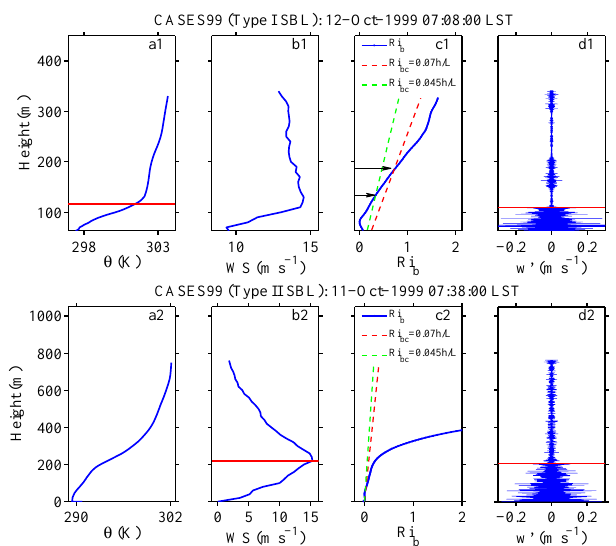
Figure 1. Examples of vertical profiles of the type I SBL (upper panels) and the type II SBL (lower panels) from CASES99 aircraft measurements: (a) potential temperature (K); (b) horizontal wind speed (ms − 1 ); (c) bulk Richardson number Ri b and Ri bc ; (d) w perturbation (ms − 1 ). The red solid lines on (a1) and (b2) denote the PBLH calculated by the PTG and LLJ methods, respectively, and those on (d) denote the PBLH determined by the Tur method. The black arrows on (c1) denote the PBLHs determined by the bulk Richardson number method with Ri bc from Eq.